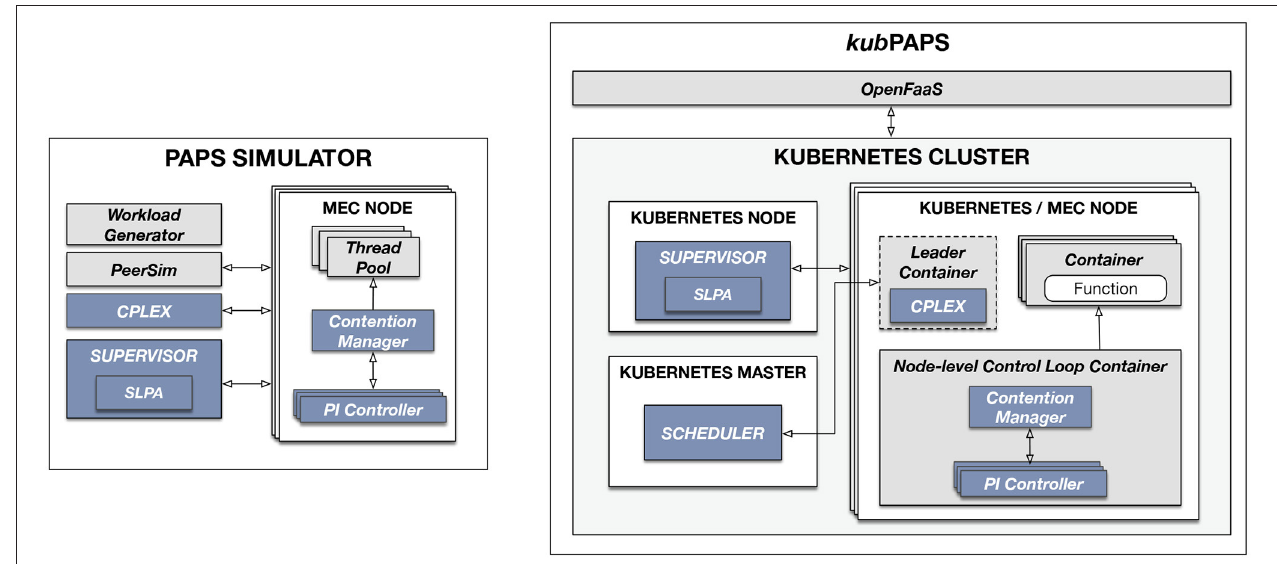
FIGURE 4 | PAPS simulator and kub